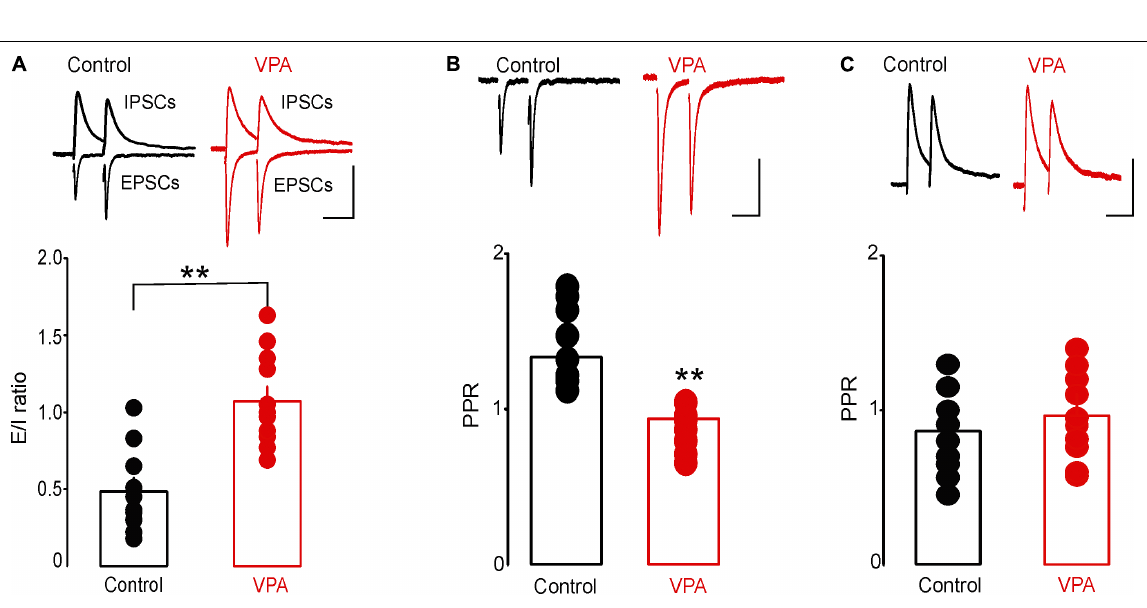
FIGURE 3 | Prenatal VPA exposure increases the synaptic excitation/inhibition (E/I) ratio by enhancing glutamatergic synaptic transmission. (A) Prenatal VPA exposure increases the synaptic E/I ratio. Upper panel depicts superimposed excitatory/inhibitory postsynaptic current (EPSC/IPSC) traces recorded from dorsal raphe nucleus 5-HT neurons in control (left traces) and VPA rats (right traces). Lower graph shows the average E/I ratio obtained in control and VPA rats. Note that prenatal VPA exposure significantly increases the E/I ratio (control: n = 10 cells; VPA: n = 11 cells, ∗∗ p < 0.01). (B) Prenatal VPA exposure increases the probability of glutamate release. Upper panel illustrates superimposed EPSC traces induced by pairs of stimuli at 30 ms inter-stimulus interval (ISI) and recorded in slices from control (left traces) and VPA rats (right traces). Lower graph illustrates the average paired pulse ratios (PPR = EPSC2/EPSC1) obtained at 30 ms ISI in control ( • , n = 10 cells) and VPA rats ( • , n = 9 cells). Prenatal VPA exposure significantly reduces the PPRs of EPSCs at ISI = 30 ms ( ∗∗ p < 0.01). (C) Prenatal VPA exposure has no effect on the probability of GABA release. Upper graph illustrates superimposed pairs of GABA A -IPSCs recorded at 30 ms ISI in slices from control (left traces) and VPA rats (right traces). Lower graph is a summary of the average PPRs (IPSC2/IPSC1) of GABA-IPSCs obtained at 30 ms ISI in control ( n = 6 cells) and VPA rats ( n = 6 cells). VPA exposure has no effect on the PPR of GABA-IPSCs at ISI = 30 ms ( p > 0.05). Data are presented as Mean ± SEM. Scale bars for the upper traces: 100 pA (vertical), 20 ms